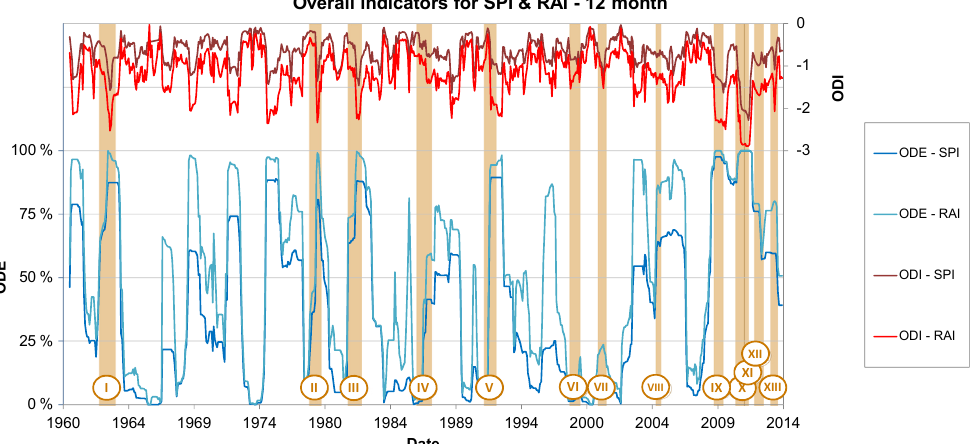
Figure A7. ODE and ODI values using the 12-month timescales of SPI and RAI indices, compared with the 13 detected historical droughts (in orange).